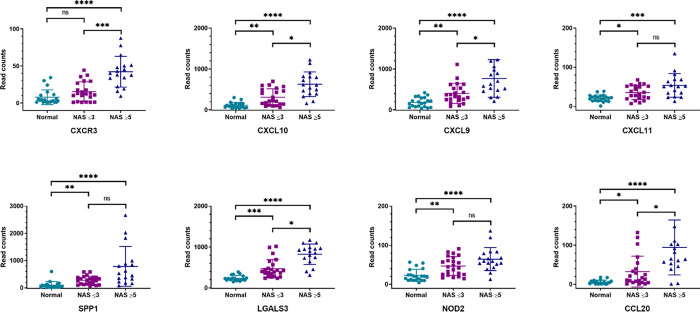
Representative transcriptional differences show stepwise increases across study groups.Individual hepatic gene expression read count comparison in normal (n = 21), NAS ≤3 (n = 23), and NAS ≥5 (n = 18) cohorts. Differences in gene expression across groups was analyzed using Kruskal-Wallis ANOVA with subsequent Dunn’s multiple comparison’s test for pairwise analysis. (* = p<0.05; ** = p<0.01, *** = p<0.001, **** = p<0.0001).